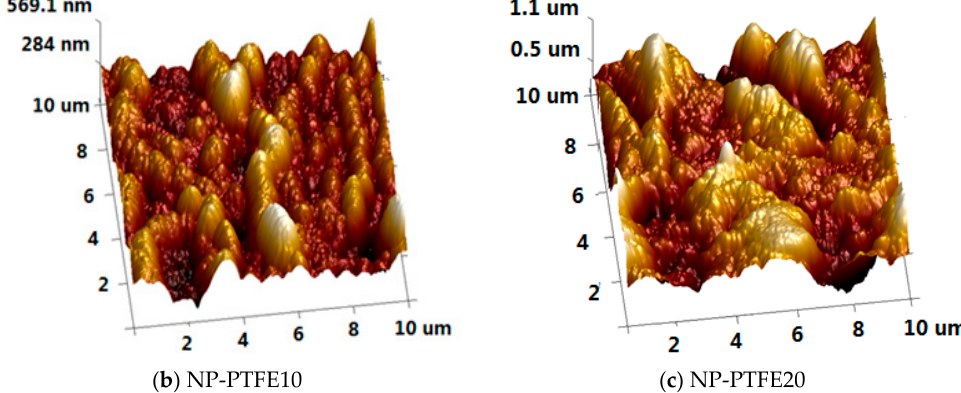
Figure 8. The atomic force microscopy (AFM) of the new pressboard, pressboard surface coated PTFE film for 10 min and 20 min.